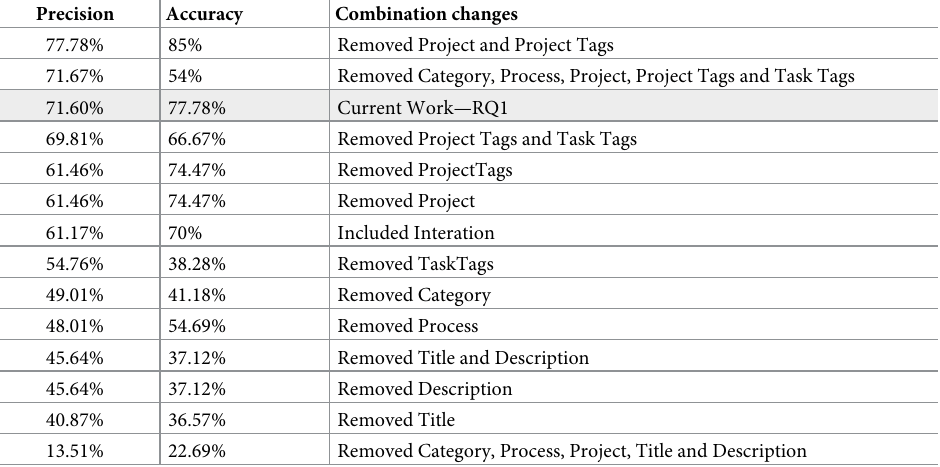
Table 7. RQ2 results: Context